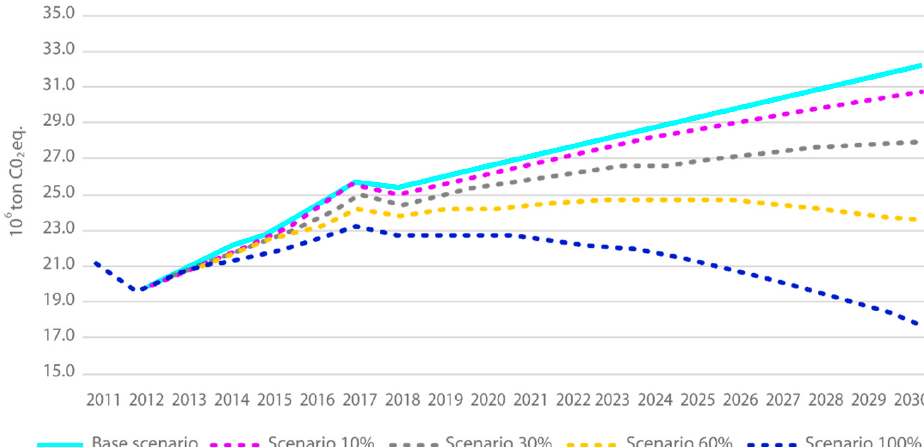
Figure 5. Evaluation of GHG emissions in the scenarios.